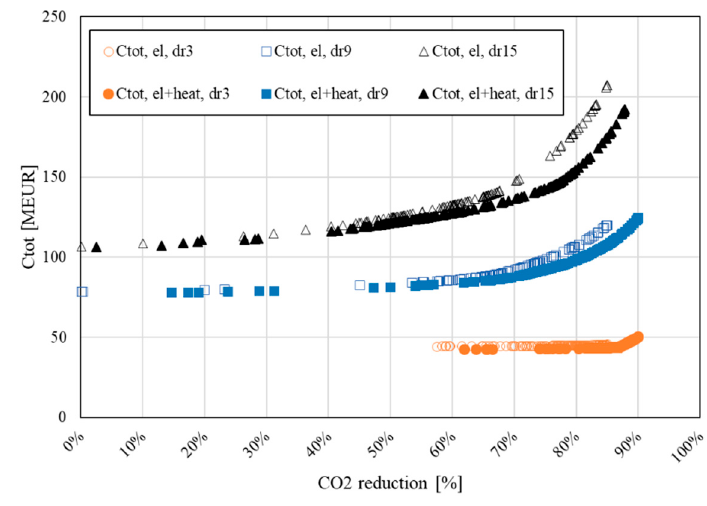
Figure 7. C tot compared for electricity only and integrated electricity and heating, p el = 40 EUR/MWh, p bio = 35 EUR/MWh.